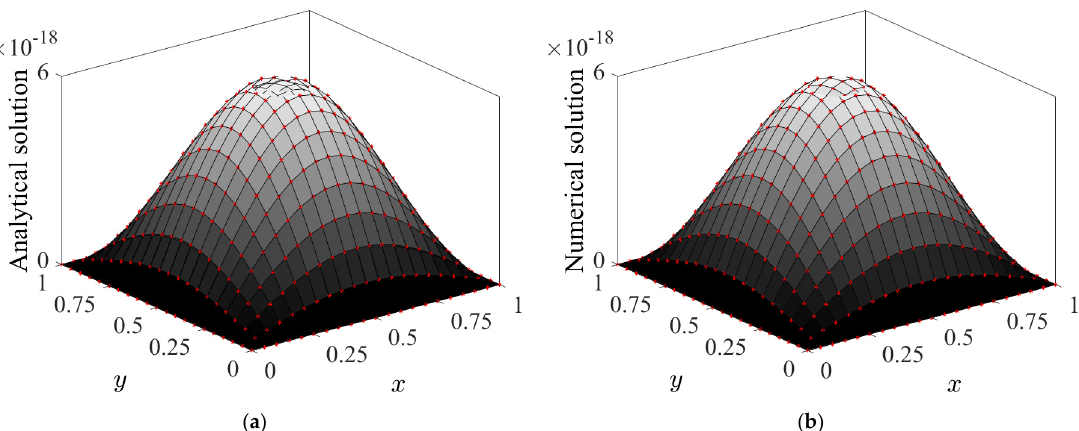
Figure 4. The absolute error norms with